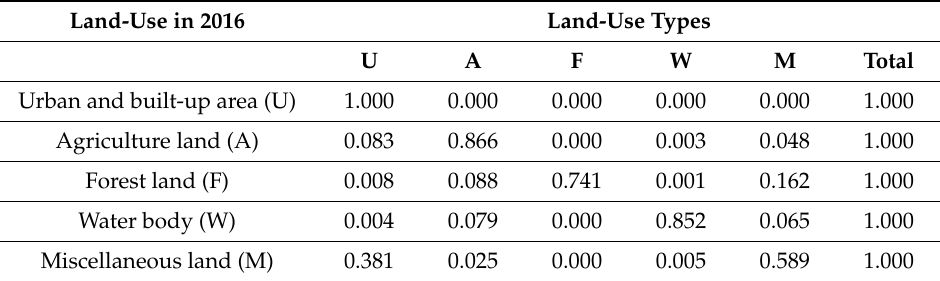
Table A6. Transition probability matrix for land-use change between 2014 and 2016. Land-Use in 2016 Land-Use Types U A F Urban and built-up area